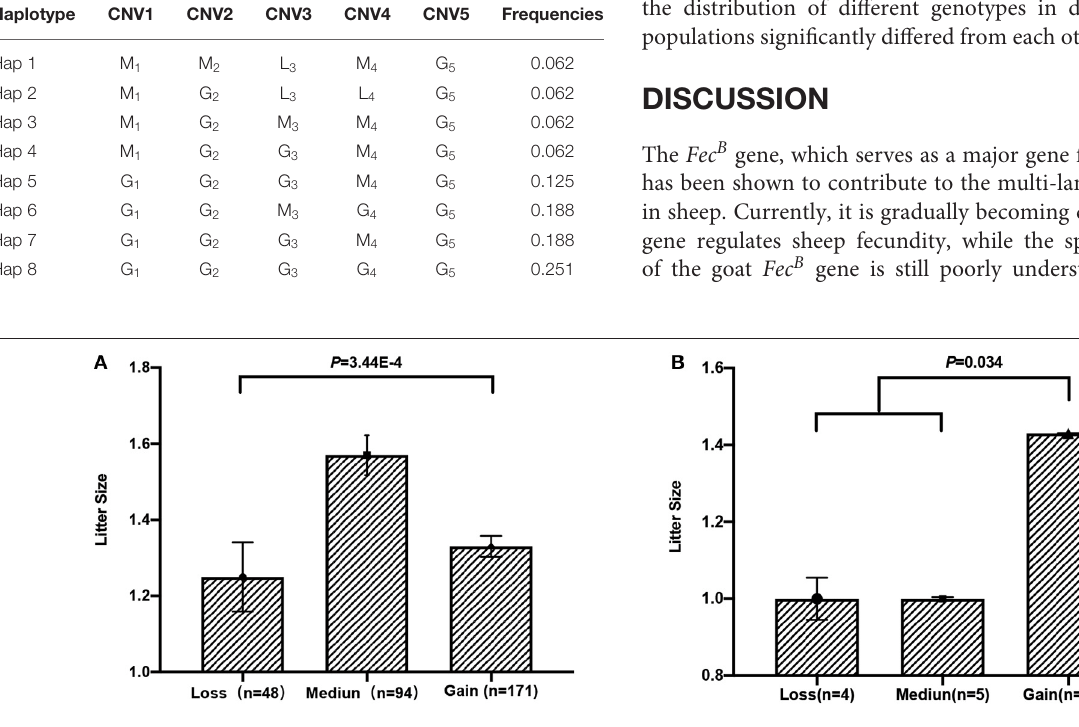
FIGURE 3 | Association analysis between litter size and copy number variations (CNVs) in Shaanbei white cashmere goats. (A) Association between CNV3 and litter size. (B) Association between CNV5 and litter size.